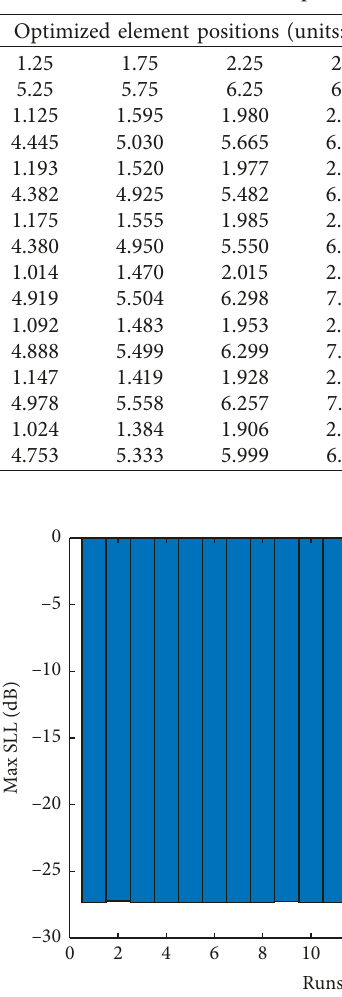
Figure 8: Distribution of maximum SLL for 20 runs of GOA for 10- element linear array in example